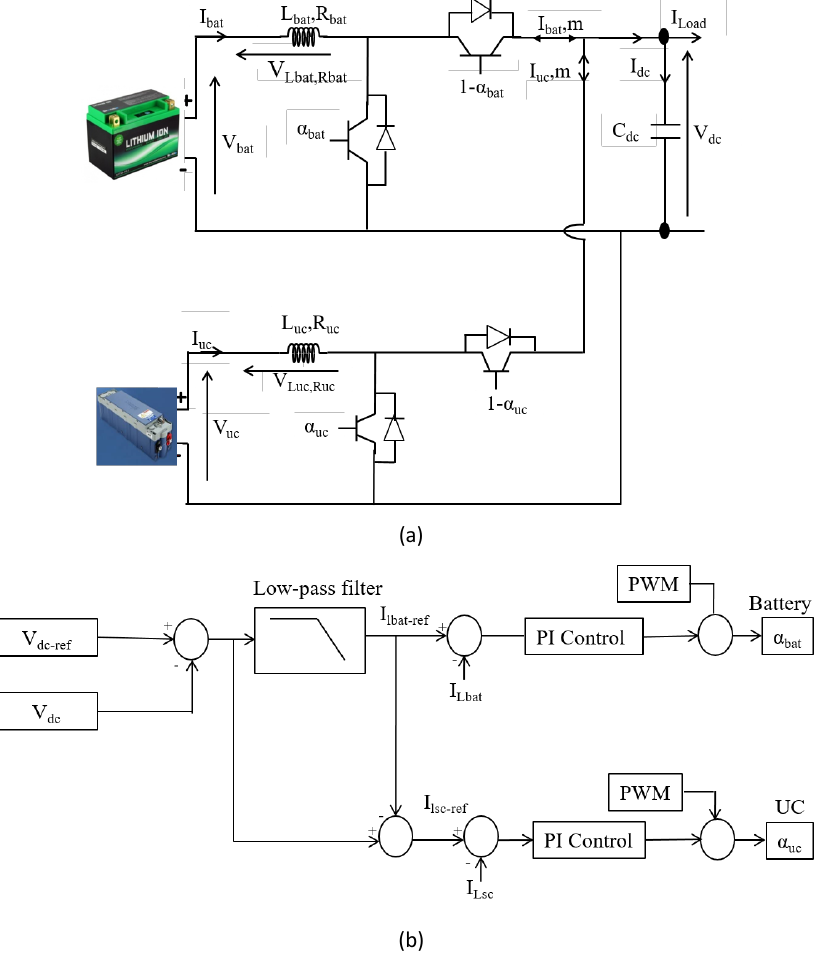
Figure 10. ( a ) Bidirectional DC-DC converters for hybrid storage system, ( b ) Frequency separation scheme of hybrid storage